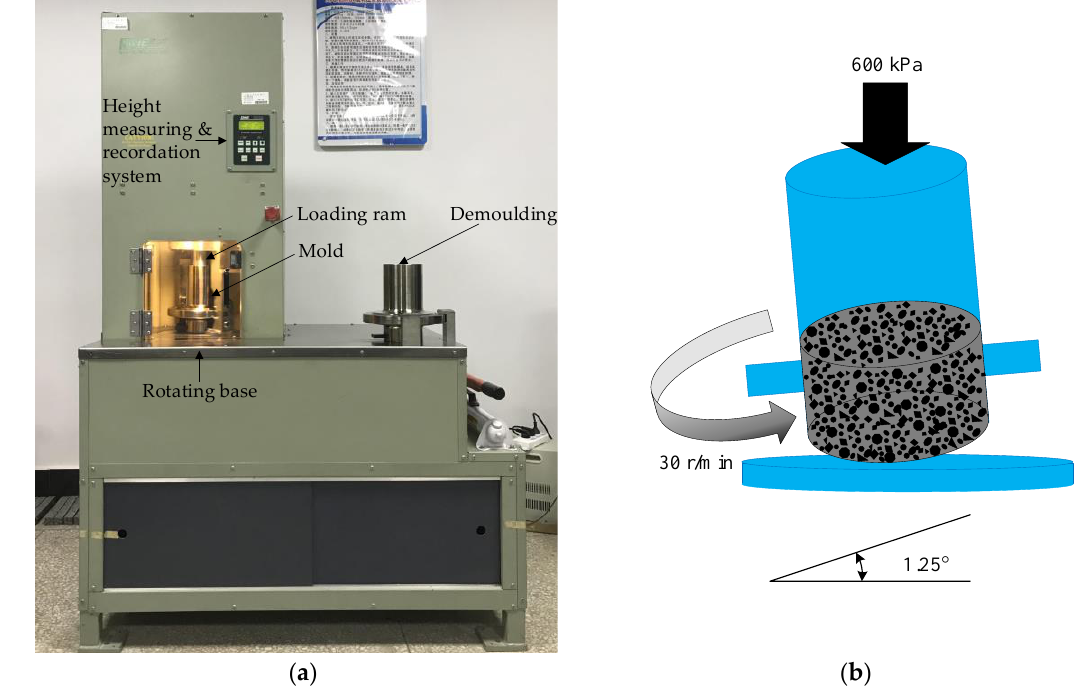
Figure 3. Superpave gyratory compaction: ( a ) SGC test and ( b ) diagram of SGC.